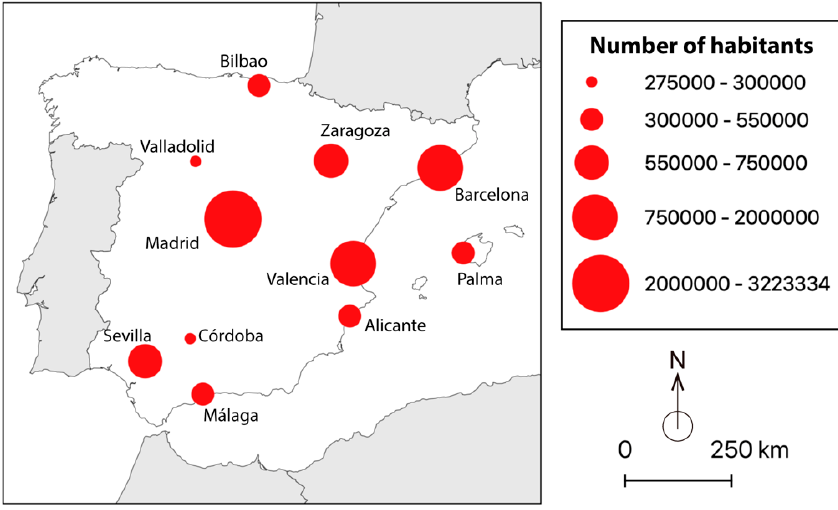
Figure 2. Location of the eleven most populated cities in Spain.